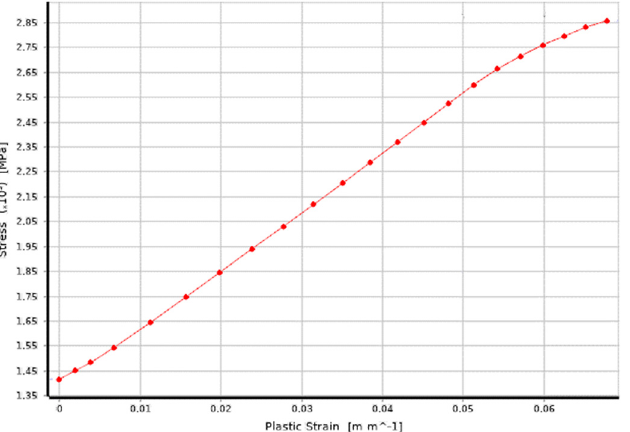
Figure 3. Non-linear model of a 6 mm thick material. The course of actual stress depends on the material deformation. The conventional yield point amounts to Re = 1417 MPa.